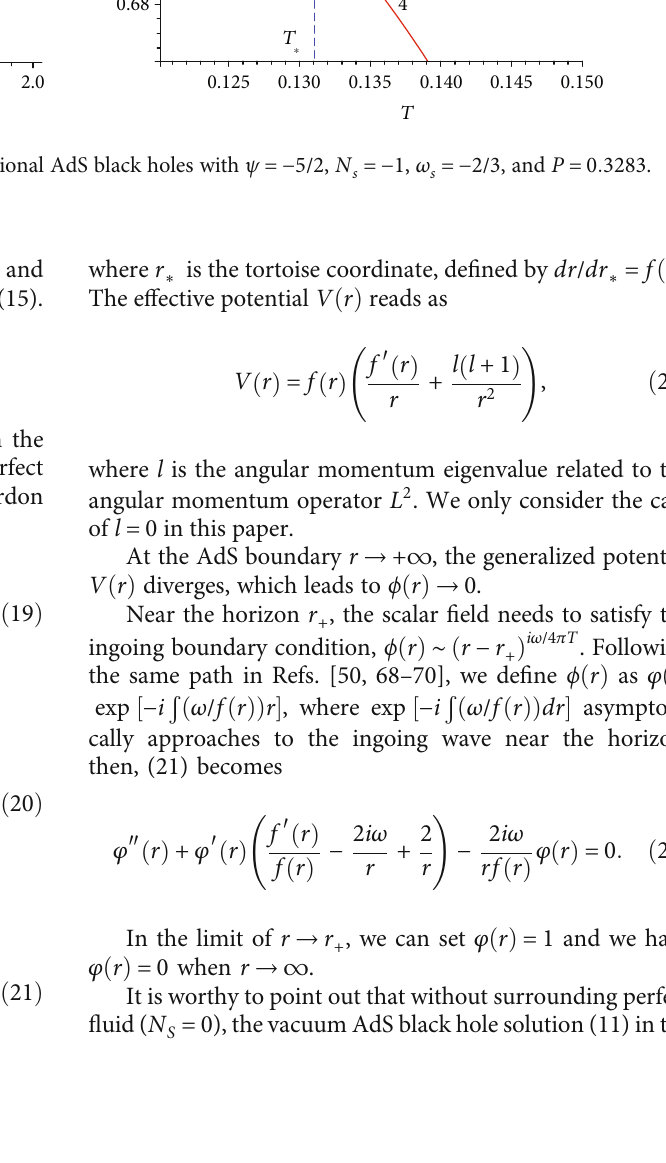
Figure 3: The T − r